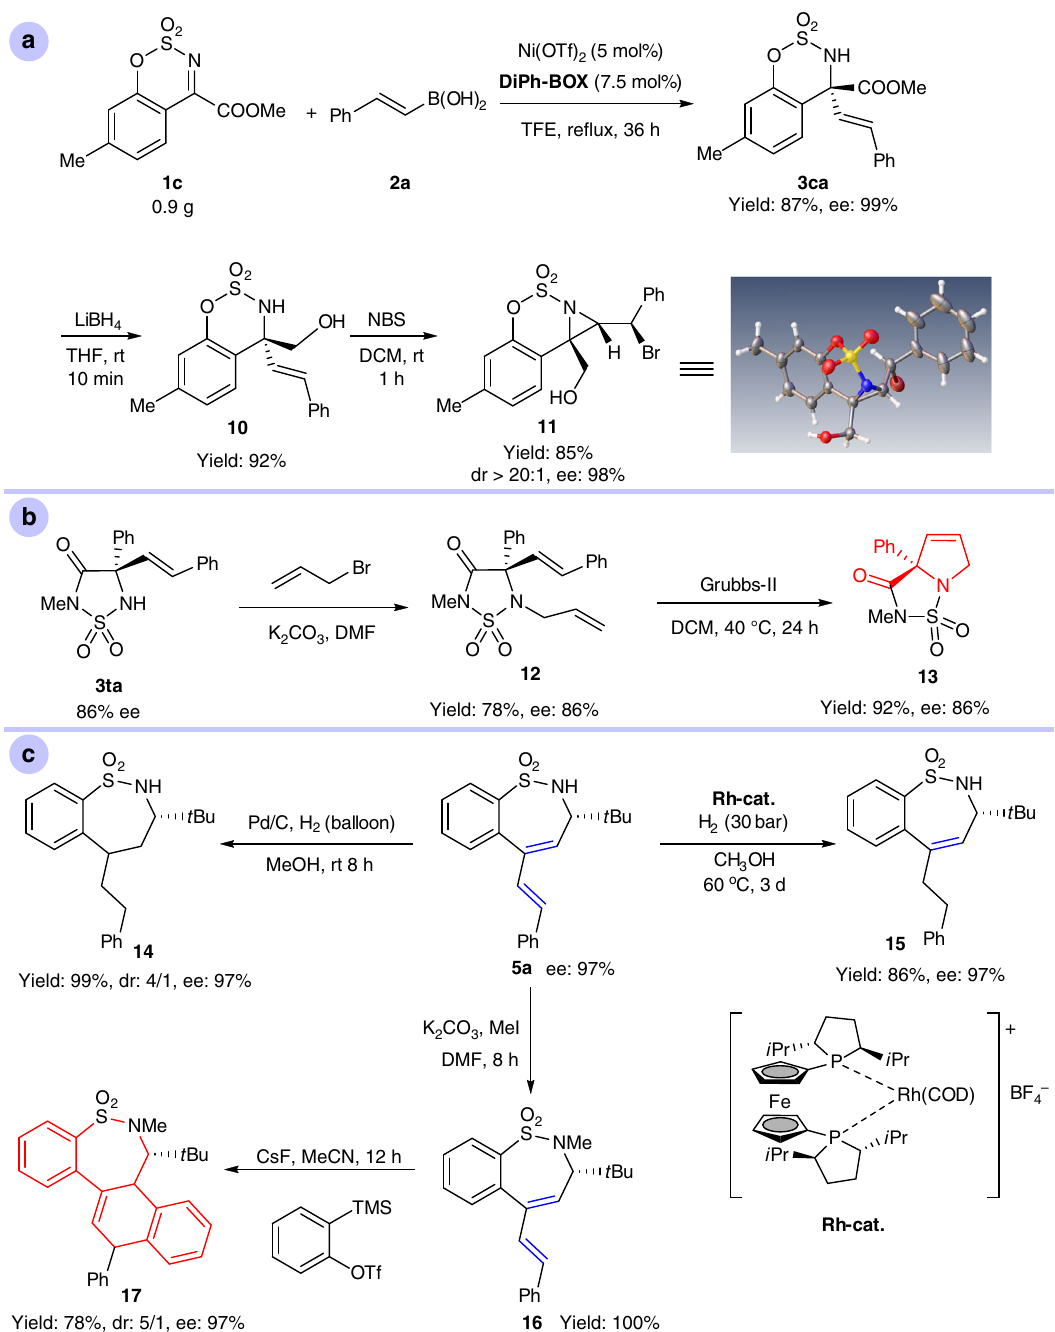
Fig. 6 Synthetic utility of alkenylation products. a Gram-scale reaction and transformations of 3ca . b Transformations of 3ta . c Further transformations of